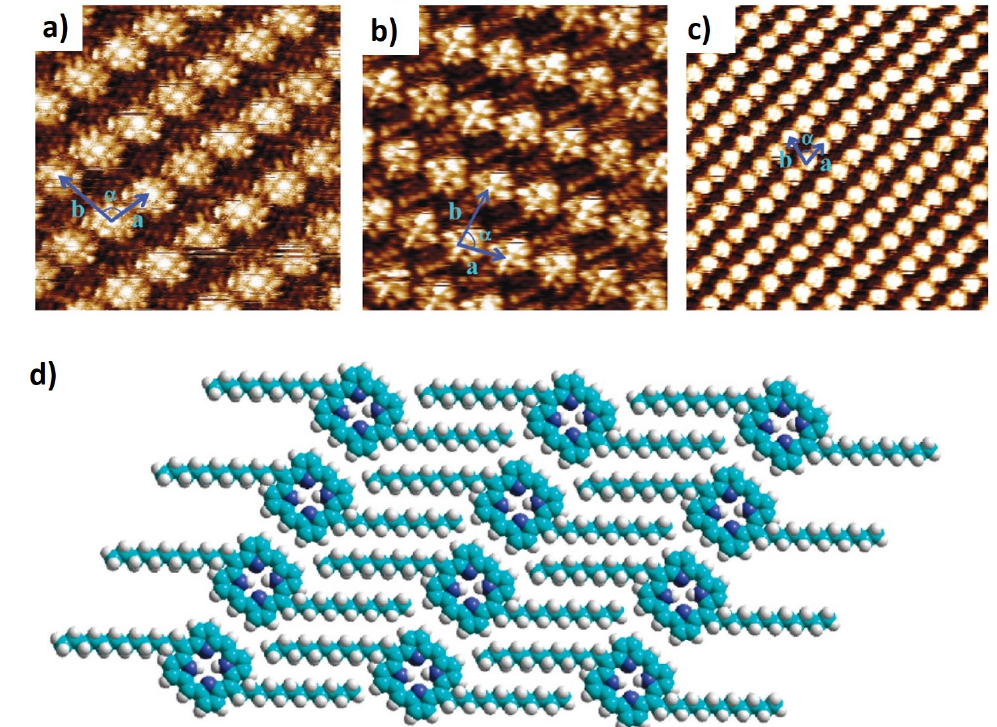
Figure 3. STM images of different self-assembled monolayers: ( a ) monolayer of non-coordinated 5,10,15,20- meso -tetradodecylporphyrin (TDP) (8.1 × 8.1 nm 2 ); ( b ) monolayer of the same porphyrin coordinated with a zinc metal-ion (ZnTDP) (9.3 × 9.3 nm 2 ); ( c ) a monolayer of 3-nitropyridine molecules that were self-assembled and coordinated to the layer underneath, a ZnTDP monolayer (20.8 × 20.8 nm 2 ); ( d ) packing arrangement model for TDP assembled on HOPG. (Reprinted with permission from reference [38]. Copyright 2016 American Chemical